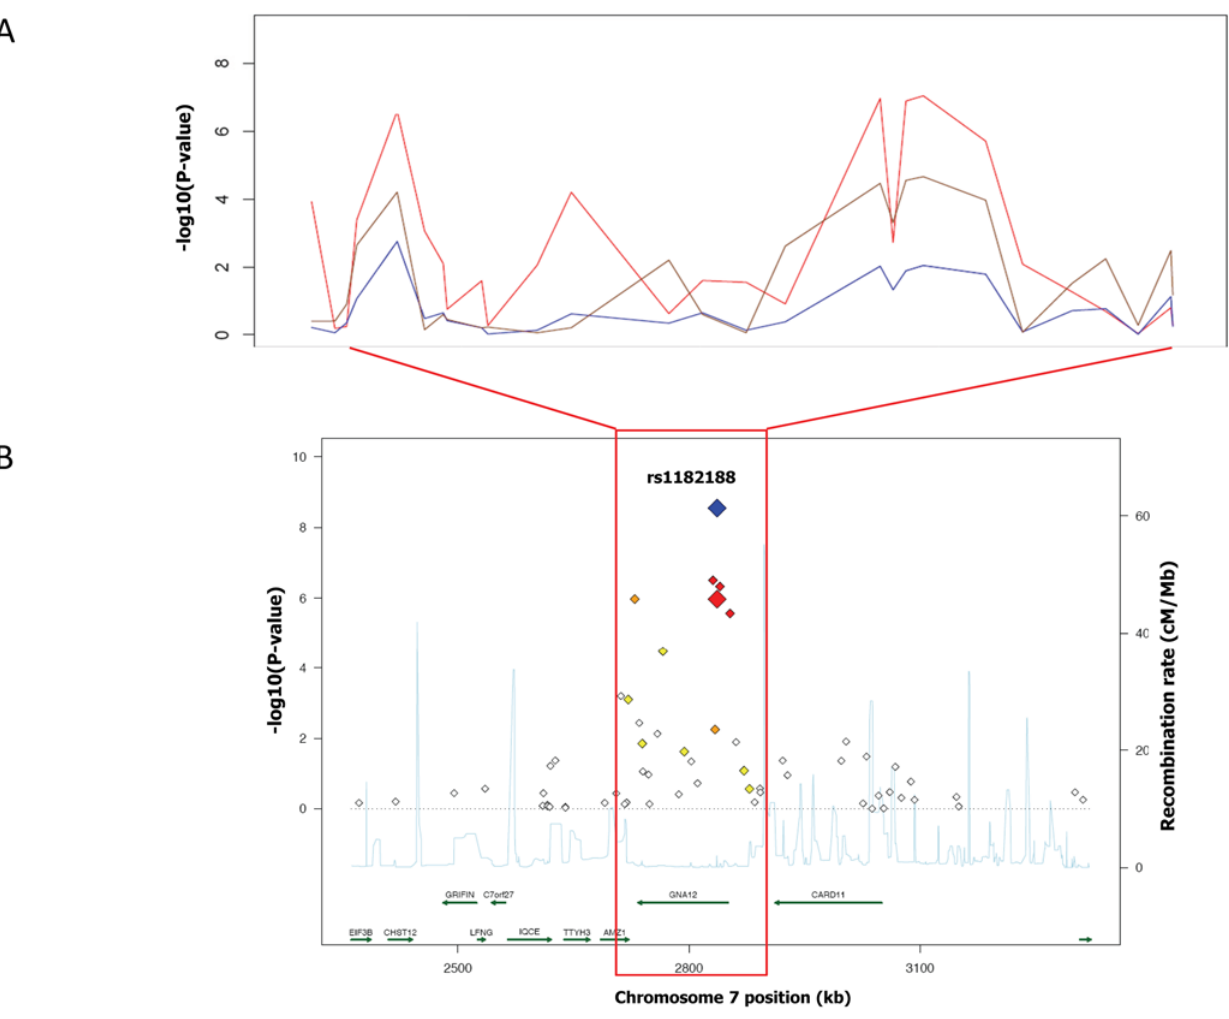
Figure 1. Association with gene expression in the GNA12 region. (A) P -values, expressed on the 2 log10 scale, for associations with adult height (red) and gene expression measured at probes specific for GNA12 (blue) and LOC392620 (magenta) within the 370-Kb recombination interval surrounding the lead SNP rs1182188. (B) Association signal with height in the 1 MB interval surrounding the lead SNP. The red dot indicates the association P -value for the lead SNP rs1182188 in the discovery GWAS + EPIC sample (n=12,611 individuals), the blue dot indicates the meta-analysis P -value after replication. Red diamonds indicate high LD with the lead SNP (r 2 . 0.8), orange diamonds indicate moderate LD with the lead SNP (0.5 , r 2 , 0.8), yellow indicates markers in weak LD with the lead SNP (0.2 , r 2 , 0.5), white indicates either no LD with the lead SNP (r 2 , 0.2), or loci where such information was not available.